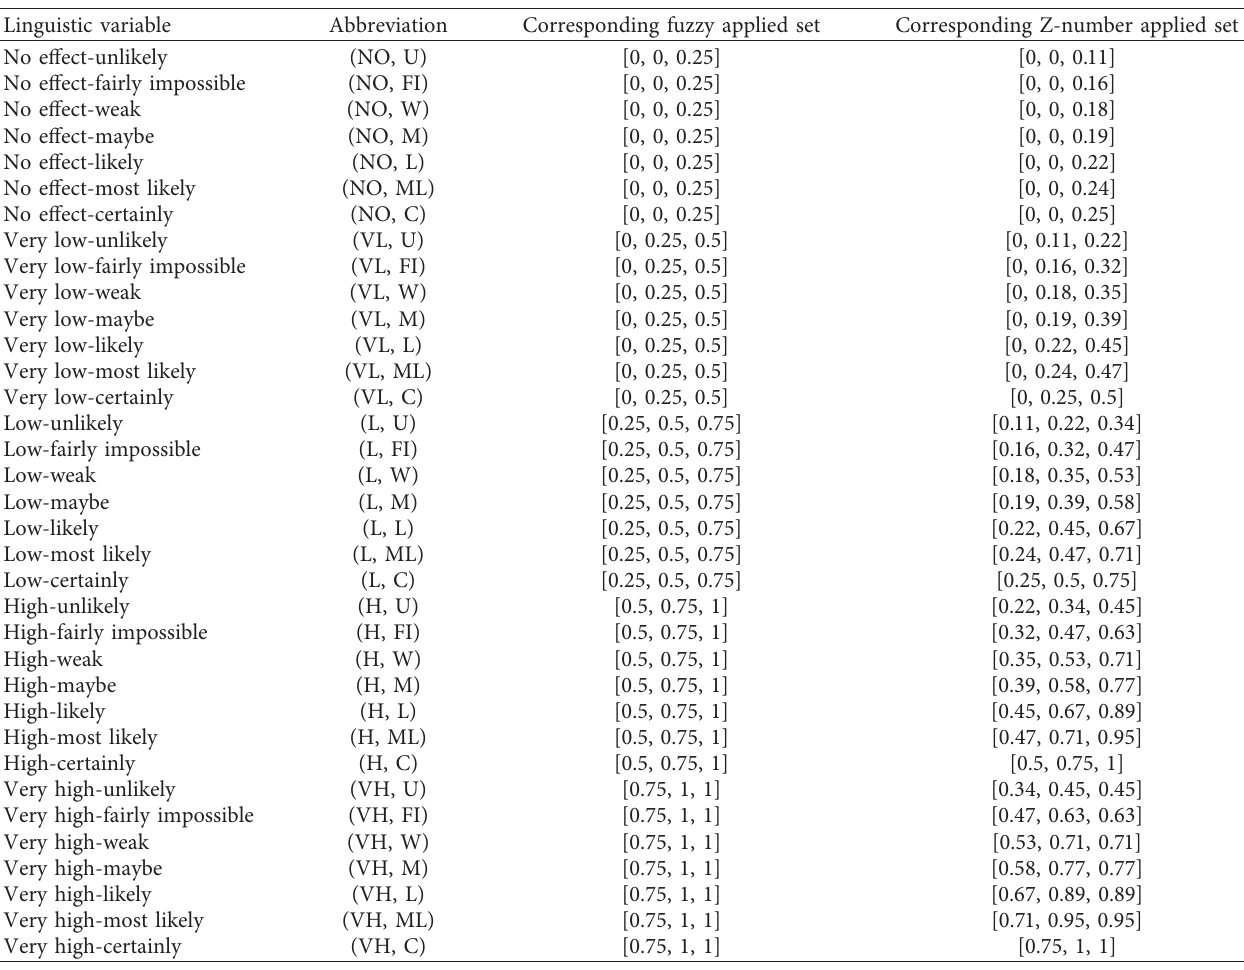
Table 4: Fuzzy Z-number corresponding